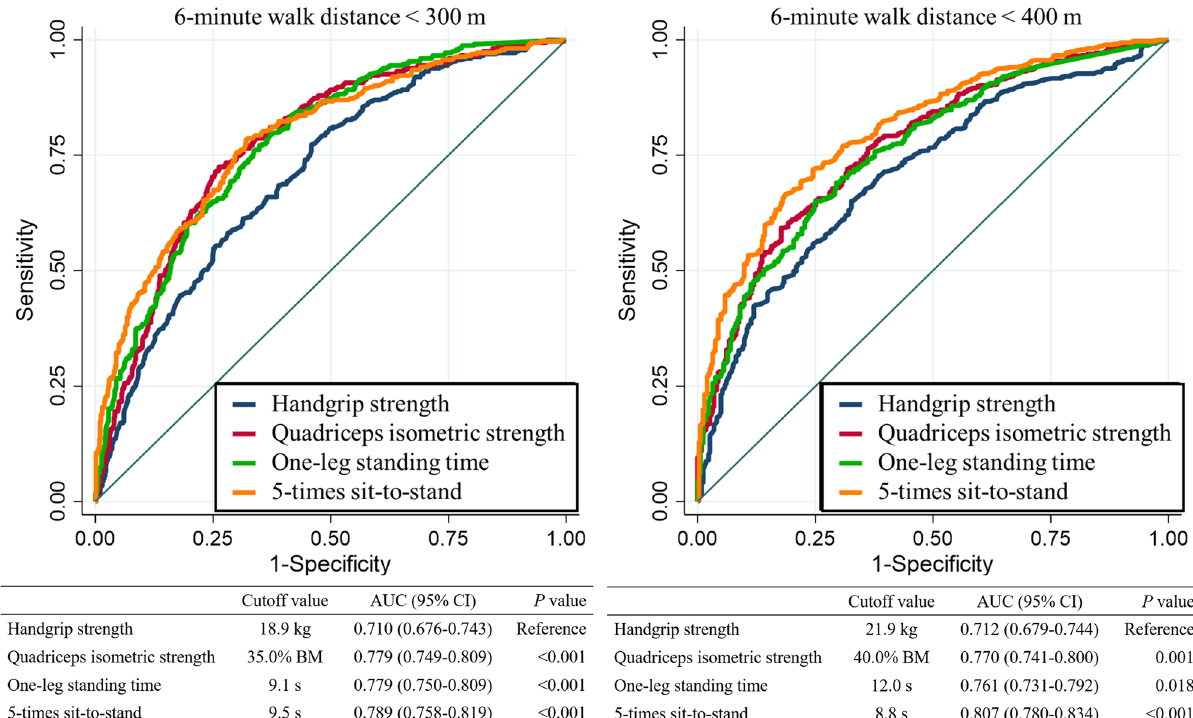
Figure 2. Receiver operating characteristic curve analysis for predicting reduced functional capacity (6-minute walk distance < 300 m and < 400 m) according to handgrip strength, quadriceps isometric strength, one-leg standing time, and 5-times sit-to-stand. 6MWD, 6-minute walk distance; AUC, area under the curve; CI, confidence